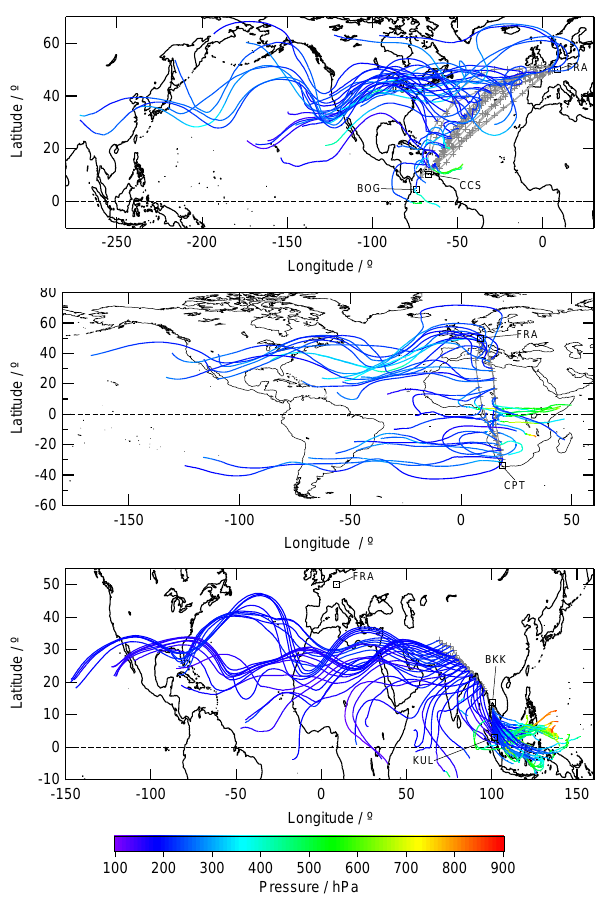
Fig. 2. 5day back trajectories for the routes sampled in this study (see http://www.knmi.nl/samenw/campaign_support/ CARIBIC/). An example of the air masses sampled along the FRA- CCS route (top); back trajectories for all samples along FRA-CPT (middle) and back trajectories for all samples along FRA-BKK- KUL (bottom).